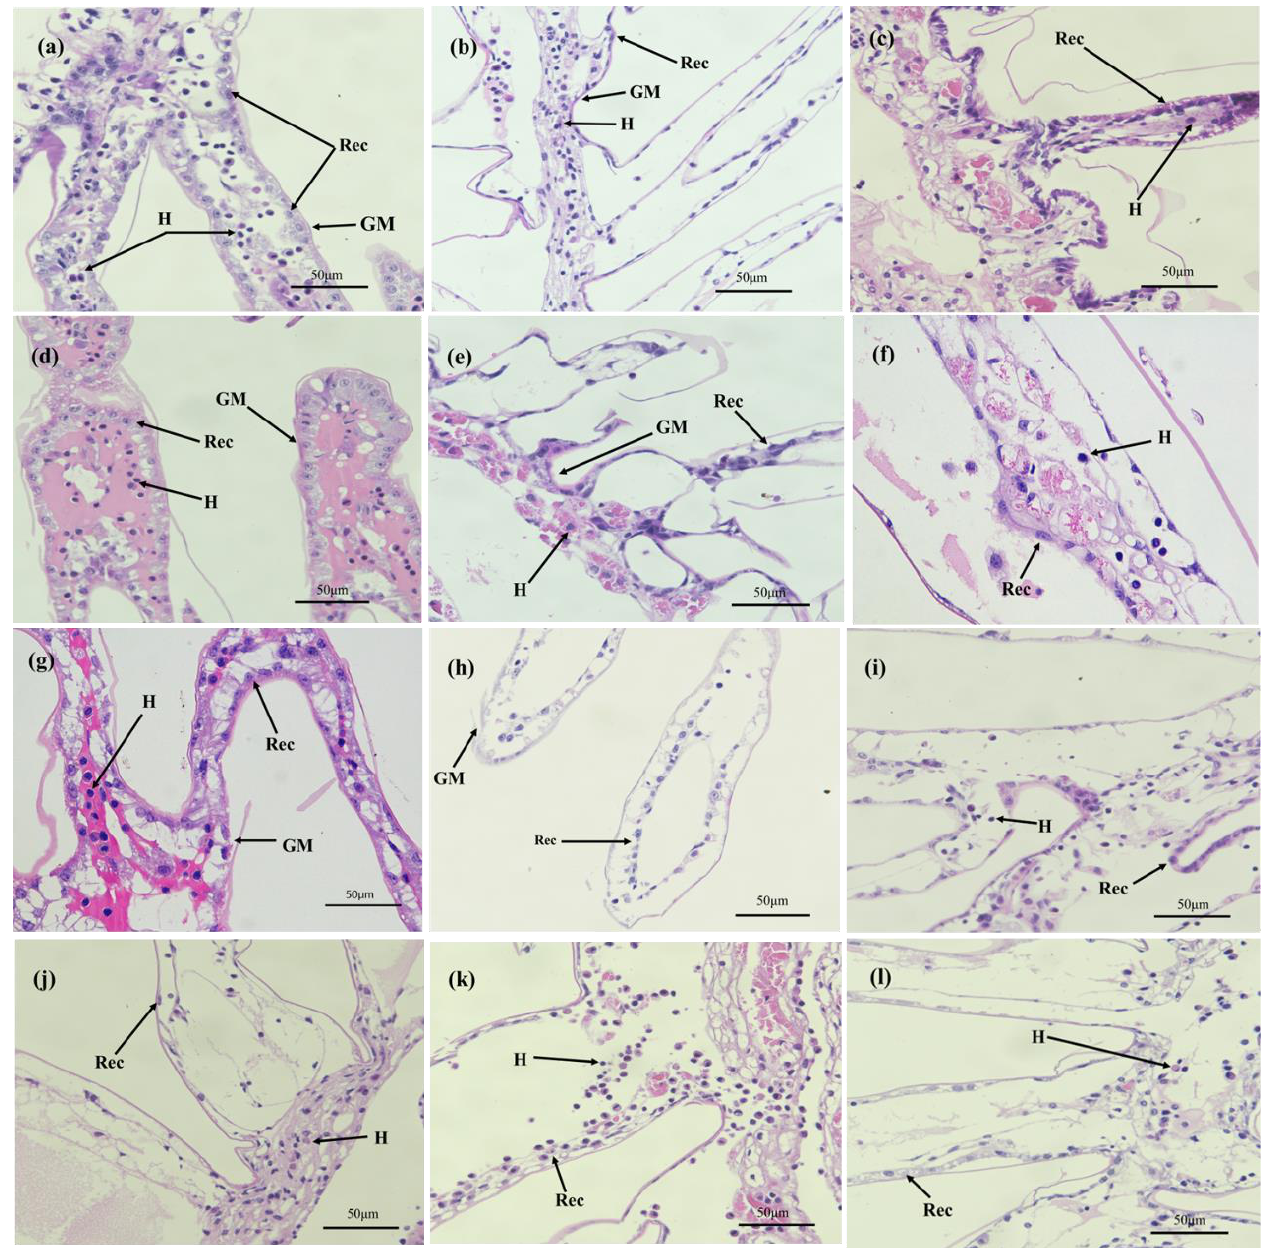
Figure 2. Effect of air exposure on gills microstructure of P. clarkii. ( a – g ) show air exposure of 0 h, 1 h, 3 h, 6 h, 9 h, 12 h, and 24 h, respectively. ( h – l ) show re-submersion of 1 h, 3 h, 6 h, 12 h, and 24 h, respectively. Rec. Respiratory epithelium cells; H. Haemocytes; GM. Gill membranes. Table 2. Histomorphology characters in hepatopancreas and gills of air-exposed and re-submersion crayfish.